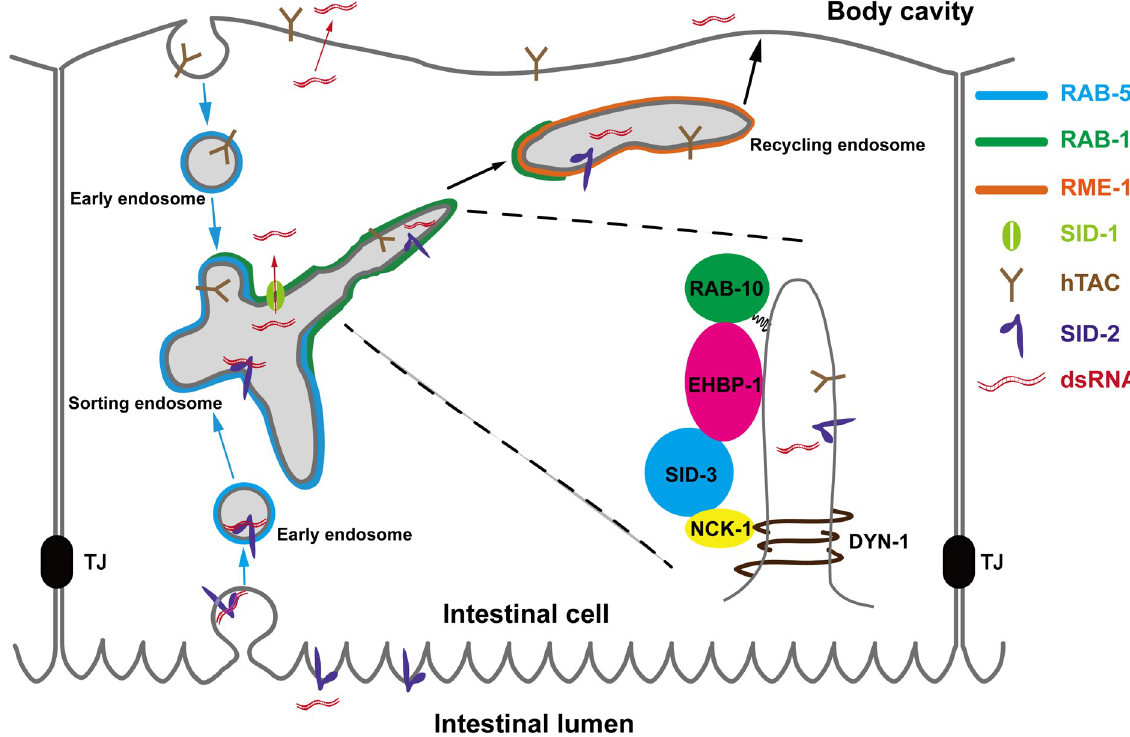
Fig 7. Model of EHBP-1 and SID-3 coordinated recycling in C . elegans intestine. There is a protein interactive cascade among EHBP-1, SID- 3, NCK-1, and DYN-1. SID-3 acts downstream of EHBP-1 to direct recycling endosomal tubules fission in concert with NCK-1 and DYN-1. The dsRNA is internalized from the intestinal lumen via SID-2-mediated endocytosis. Basolateral recycling could be involved in the transport of RNA silencing signals, facilitating the release of apically endocytosed dsRNA into the pseudocoelom (body